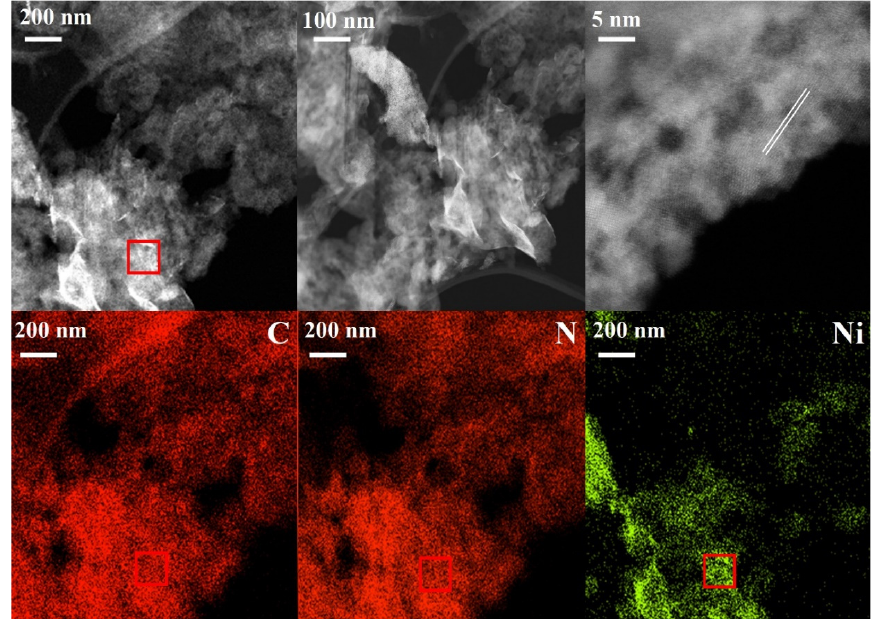
Figure 4. TEM images at different resolution and EDX mapping (from top left image) of Ni CM .